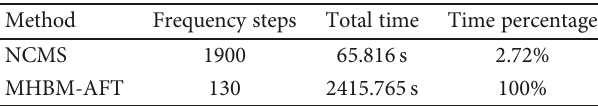
Table 4: Comparison of computation time of the tuned blisk with SSDNC.